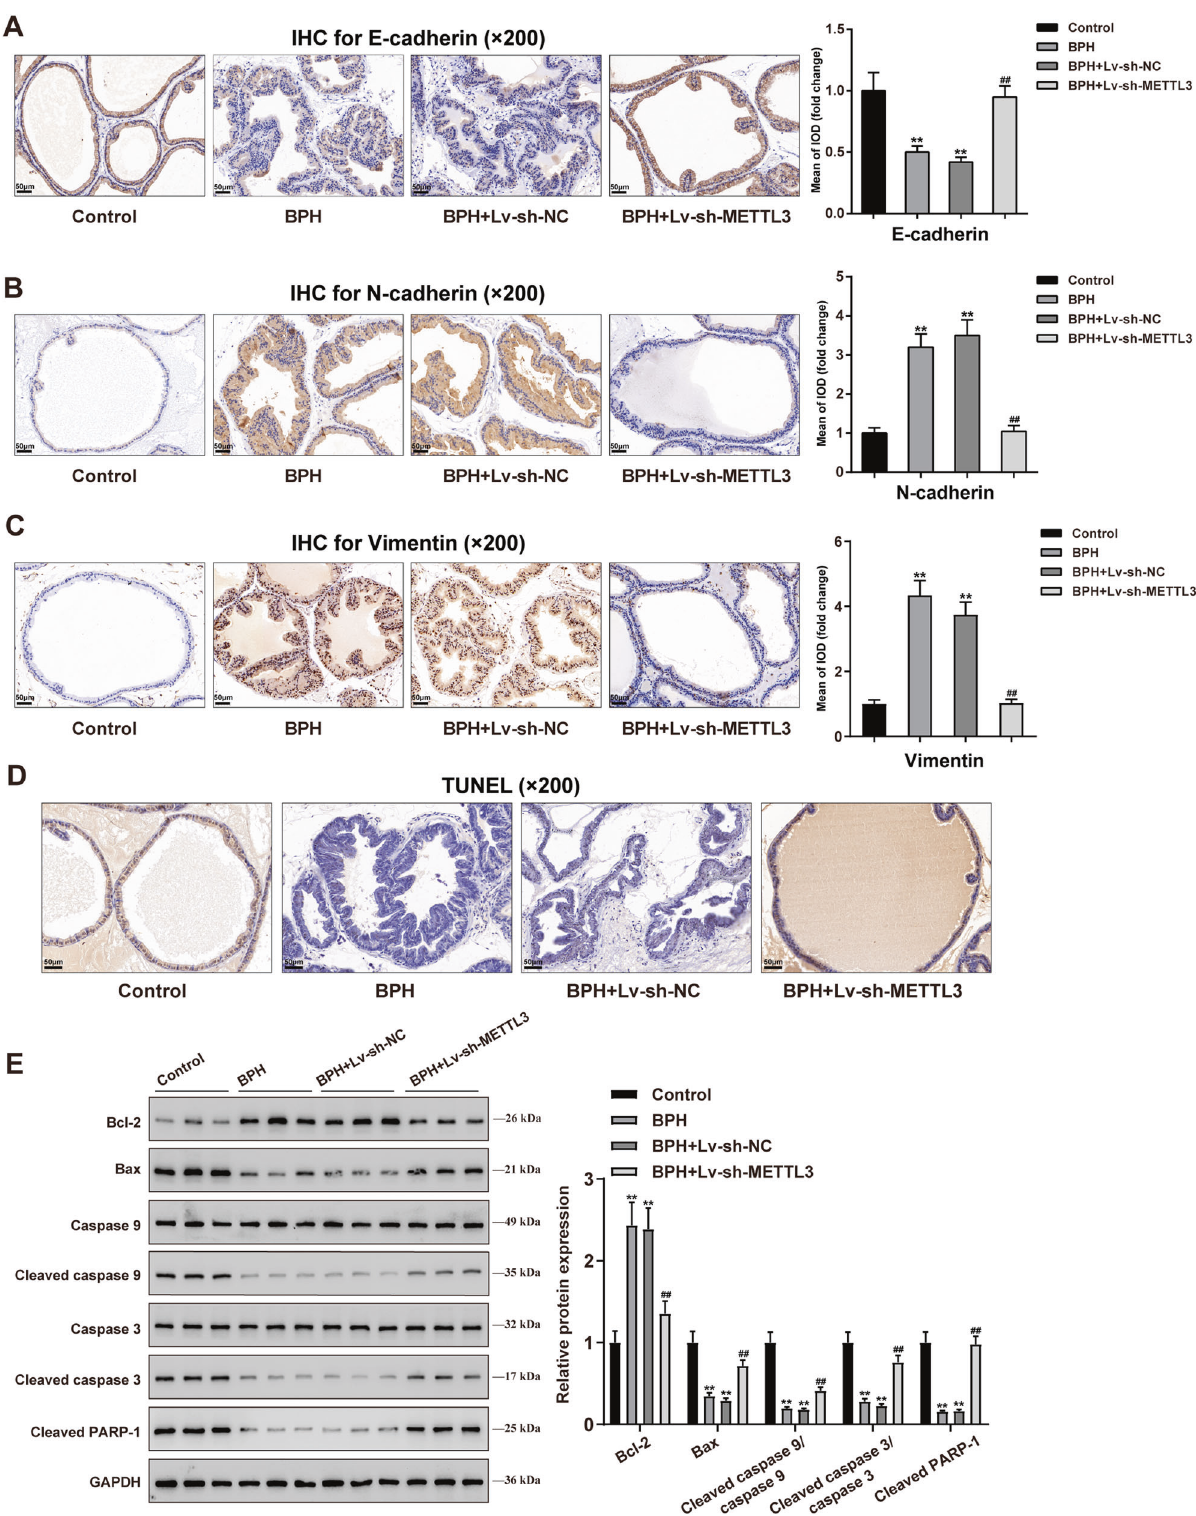
Fig. 2 METTL3 knockdown inhibits epithelial-mesenchymal transition (EMT) protein expression and promotes apoptosis in rats ’ hyperplasic prostate. A – C The contents of E-cadherin ( A ), N-cadherin ( B ), and Vimentin ( C ) in rats ’ prostate tissues were determined using IHC staining. D Cell apoptosis in rats ’ prostate tissues was determined using a TUNEL assay. E The apoptosis-related proteins (Bcl-2, Bax, Caspase 9, cleaved caspase 9, Caspase 3, cleaved caspase 3, and cleaved PARP-1) levels in prostate tissues in each group were detected by Immunoblotting. All scale bar = 100 μ m. ** P < 0.01, compared with the control group; ## P < 0.01, compared with the BPH + Lv-sh-NC group.